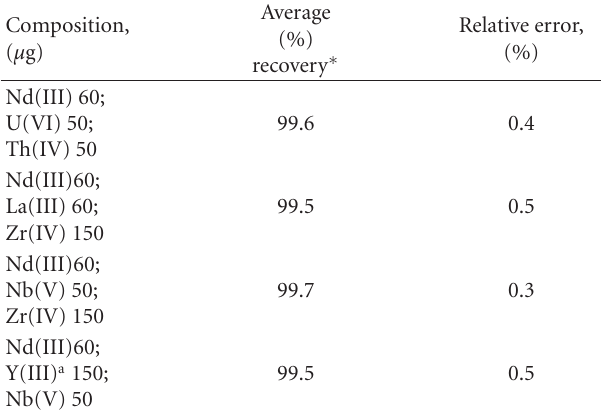
Table 5: E ff ect of various diverse ions. Nd(III) = 60 μ g pH = 6.00, sodium succinate = 0.06 M, Aq: Org = 25 :10, N- n -octylaniline = 0.1M in xylene (10mL), equilibrium time = 5min, and strippant =